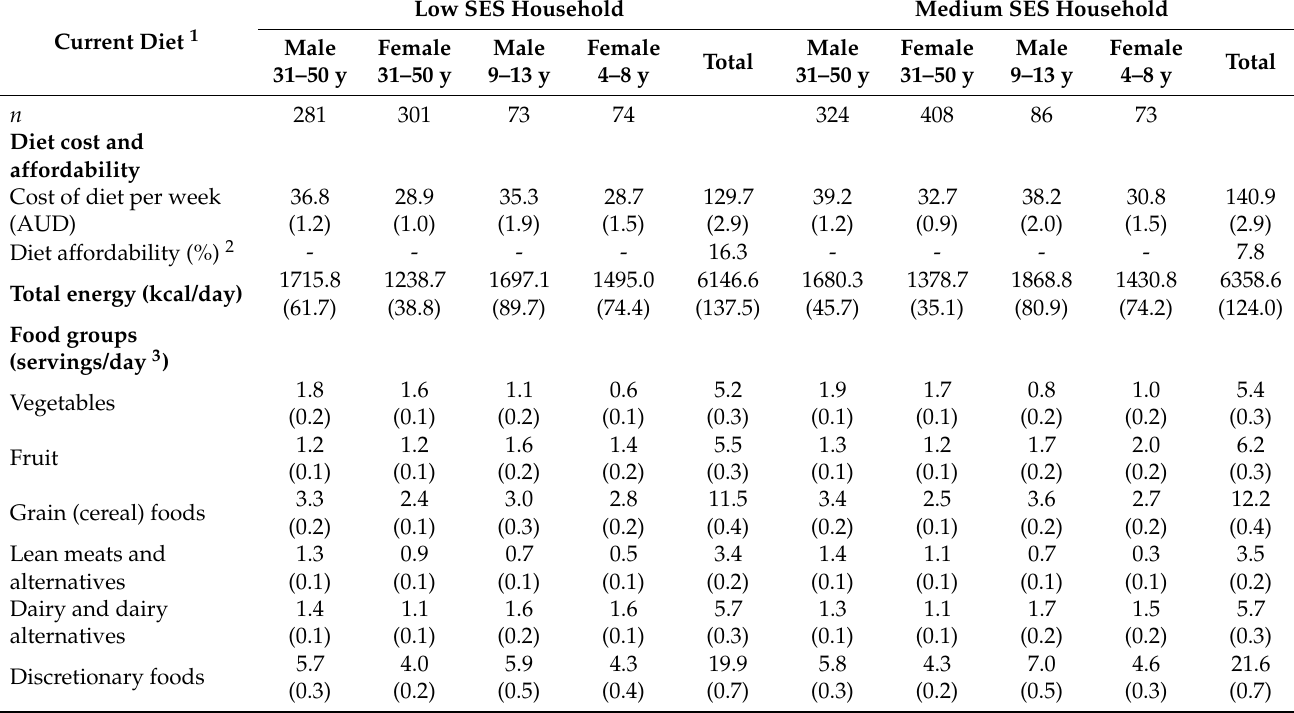
Table 4. The current Australian diet for each member of the reference household, for both low and medium SES